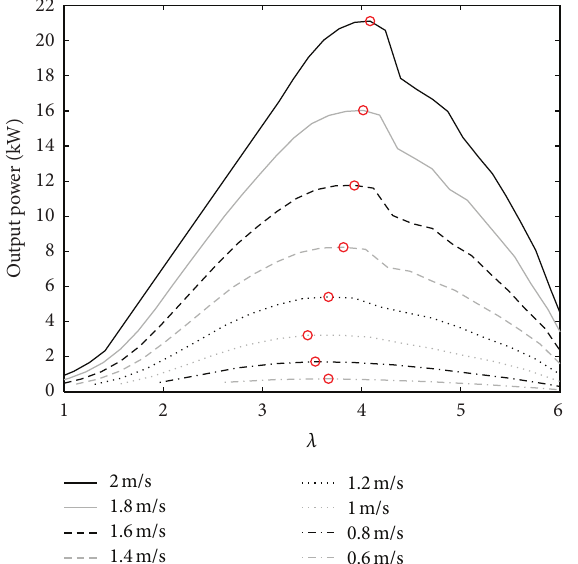
Figure13:Dutycycleoftheloadversusrotationalspeedfordifferent water velocities. The operating point with maximum power output is marked in each curve with a red